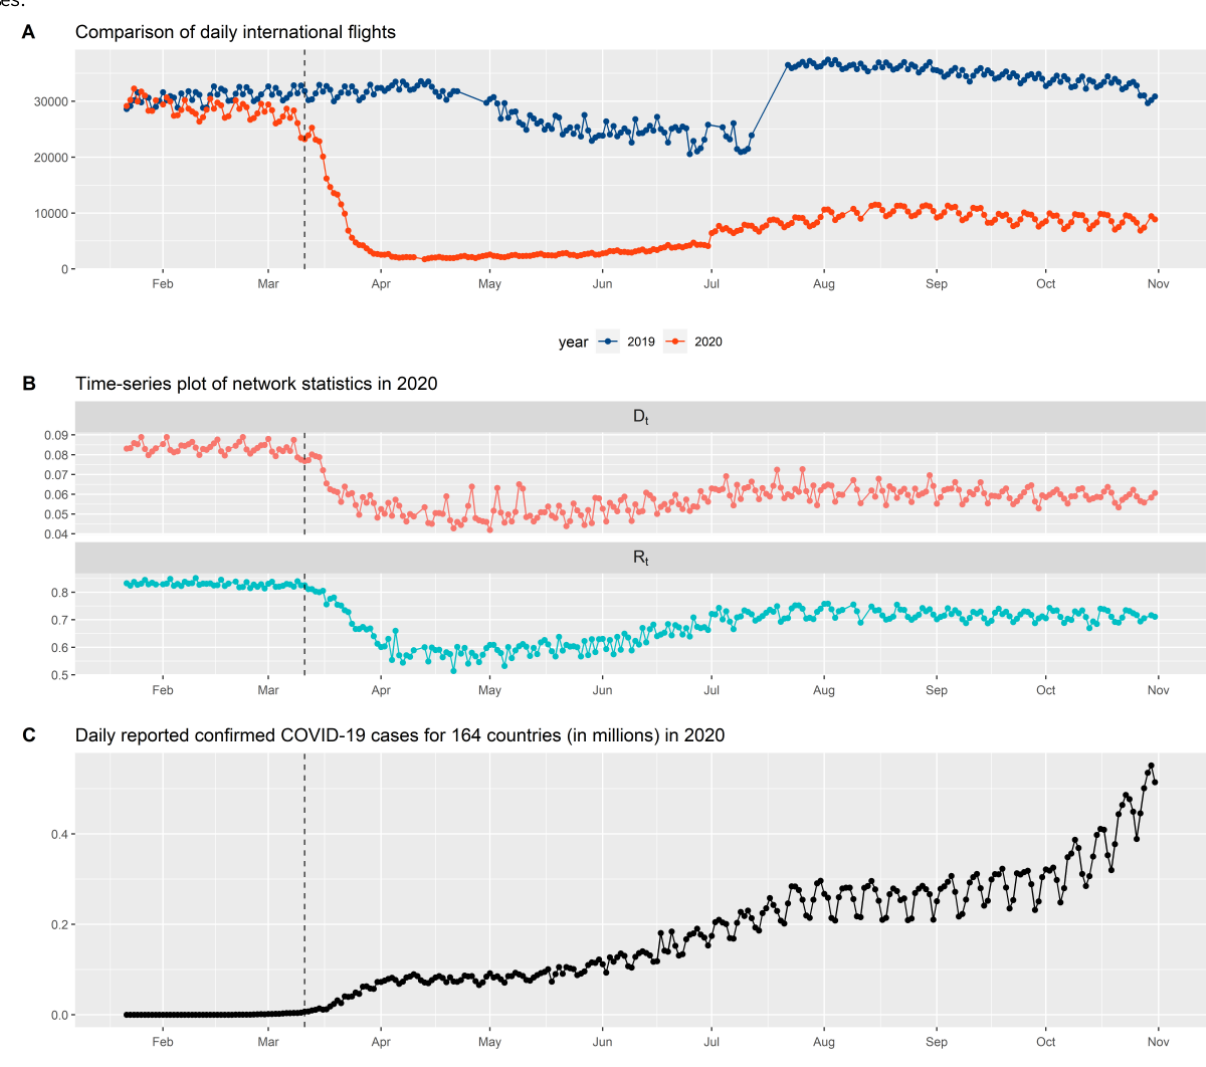
Figure 2. Time-series plots of (A) daily international flights, (B) global network statistics, and (C) daily reported number of confirmed COVID-19